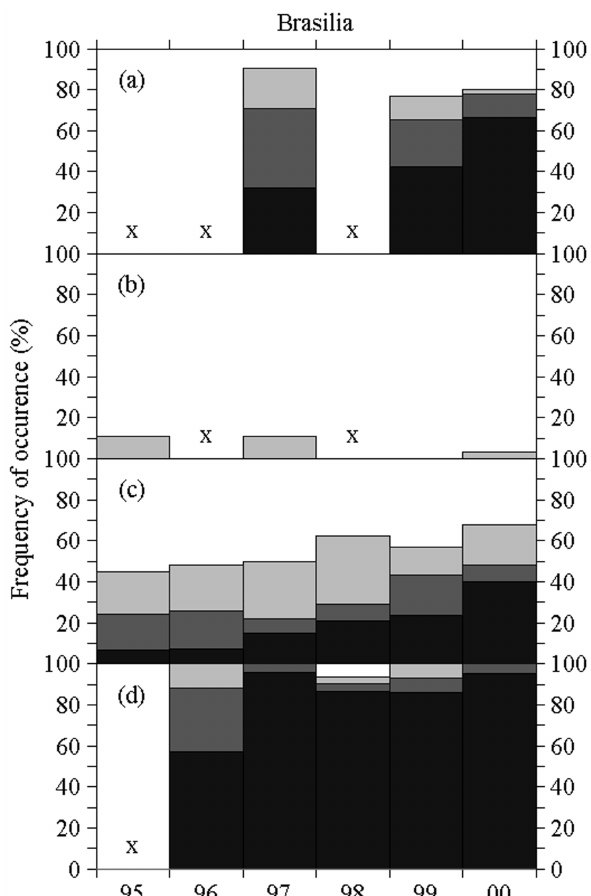
Fig. 5. The solar activity variations of GPS phase fluctuations in dif- ferent months during 1995–2000 over Brazil (gray, dark, and black denote the frequency of occurrence of Fp > 50, 100, and 200, re- spectively): (a) March, (b) June, (c) September, and (d) December. The cross symbols denote missing